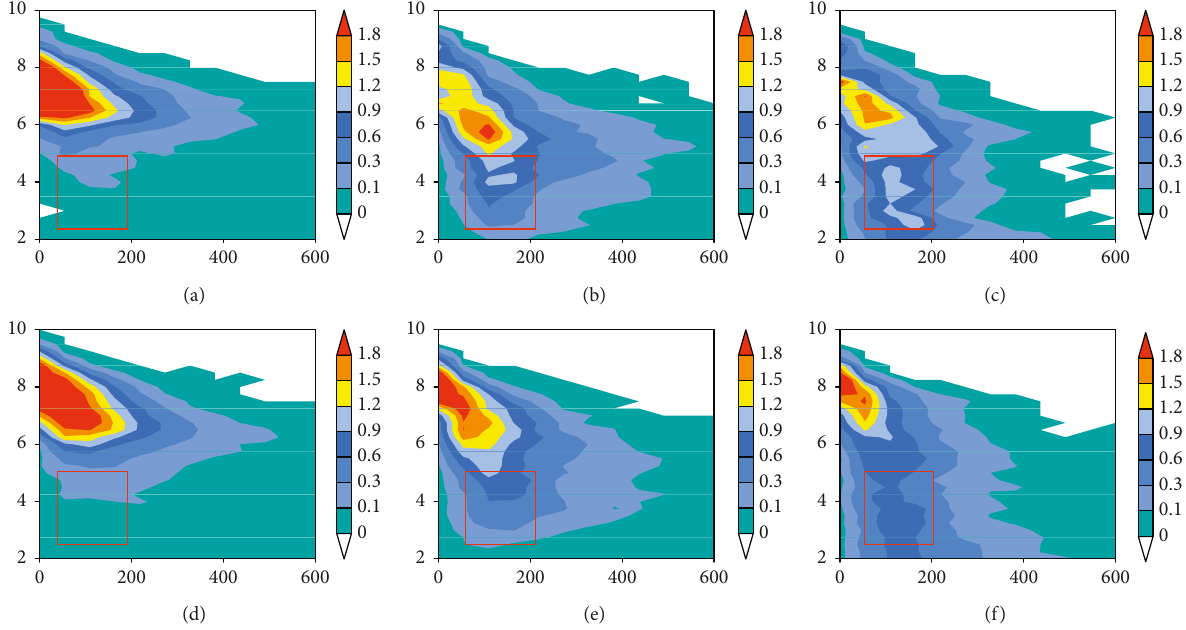
Figure 10: The vertical distribution of the number concentration of cloud droplets corresponding to different types of TPV category cloud clusters over each key region (same as above): (a) lwc_TP (LR); (b) lwc_ESTP (LR); (c) lwc_MYR (LR); (d) lwc_TP (HR); (e) lwc_ESTP (HR); (f) lwc_MYR